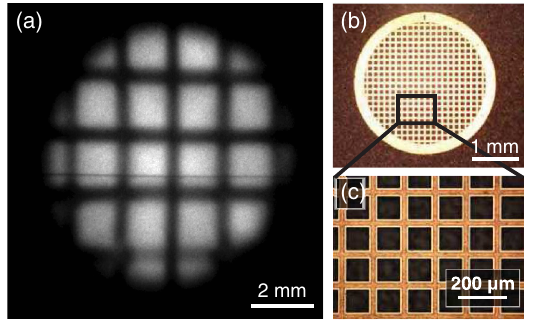
FIG. 5. (a) Electron beam shadow image on the detector screen 2.1 m after the TEM grid. The image of the grid appears magnified by a factor of 12.8. (b), (c) Optical microscope images of the 200 mesh TEM grid.